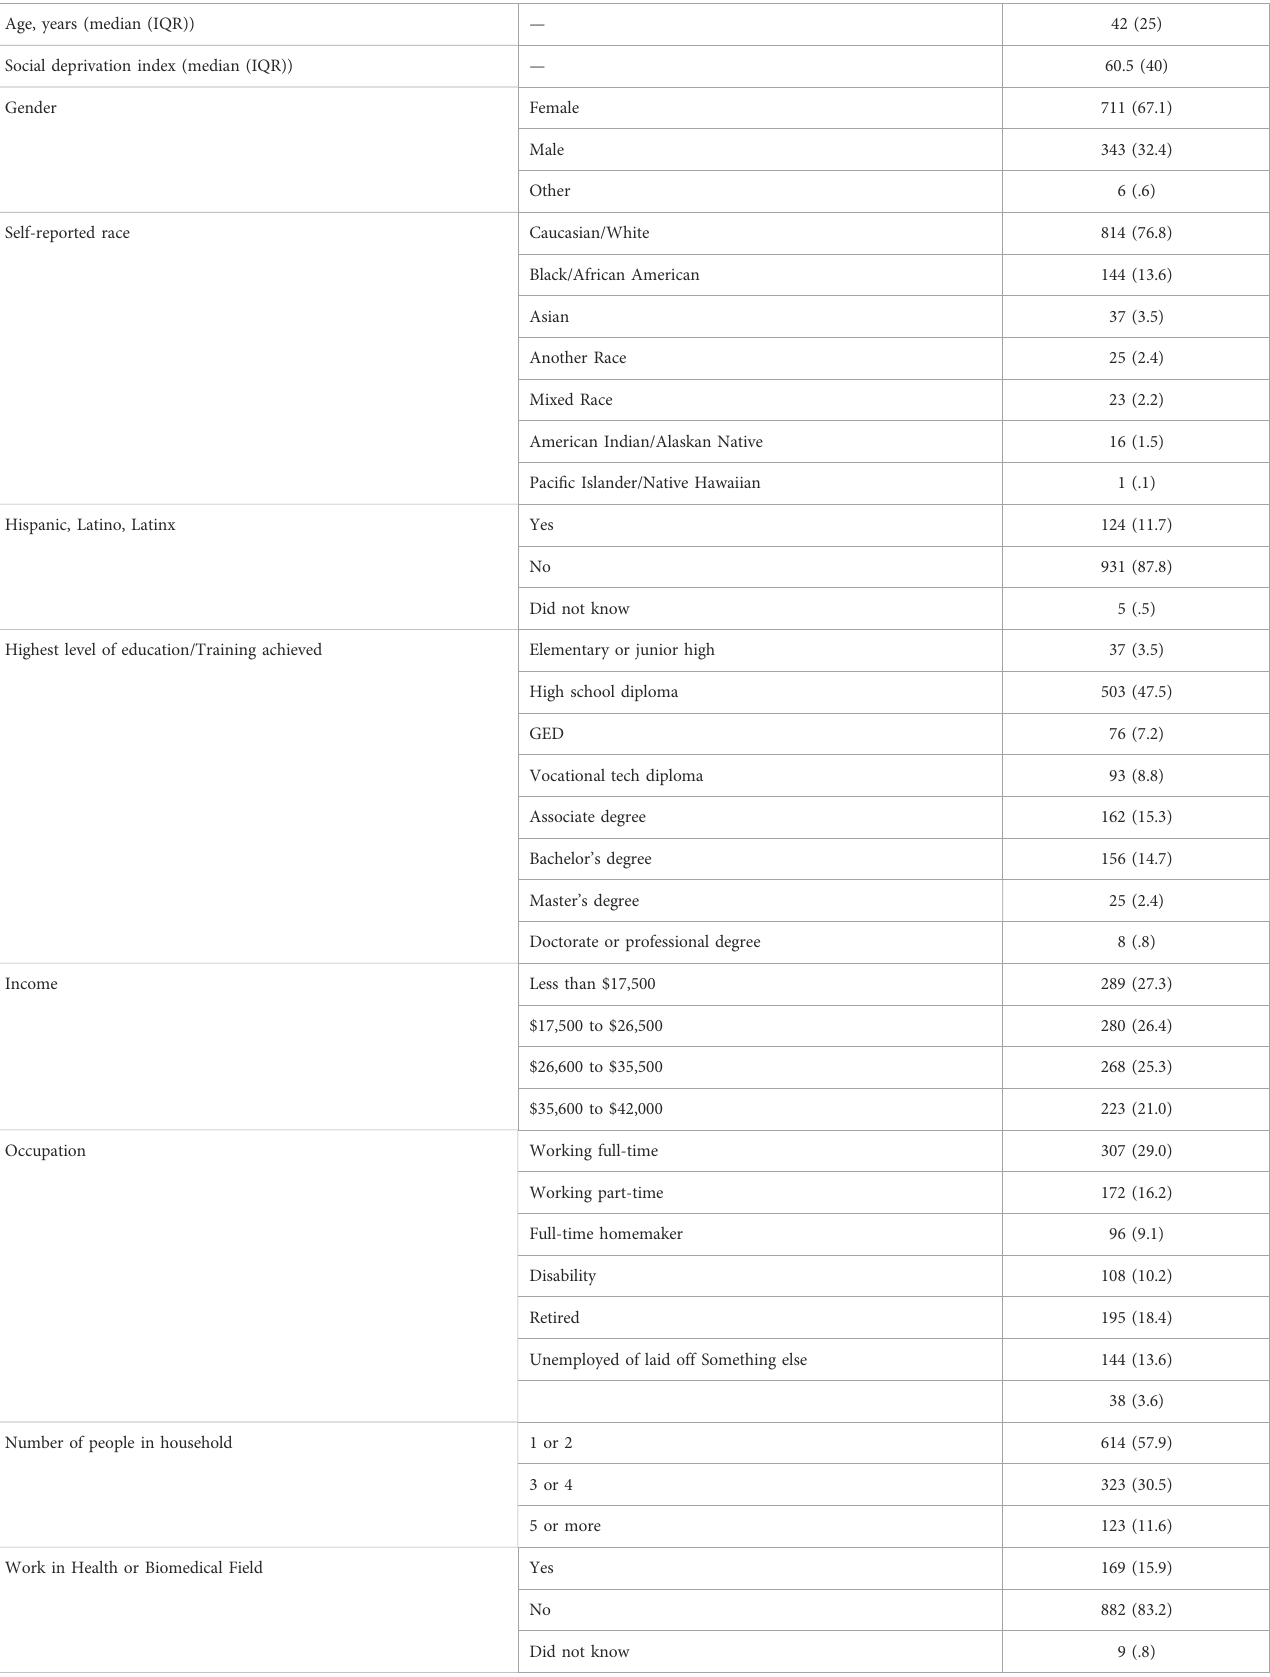
TABLE 1 Respondent demographics ( n = 1,060) a